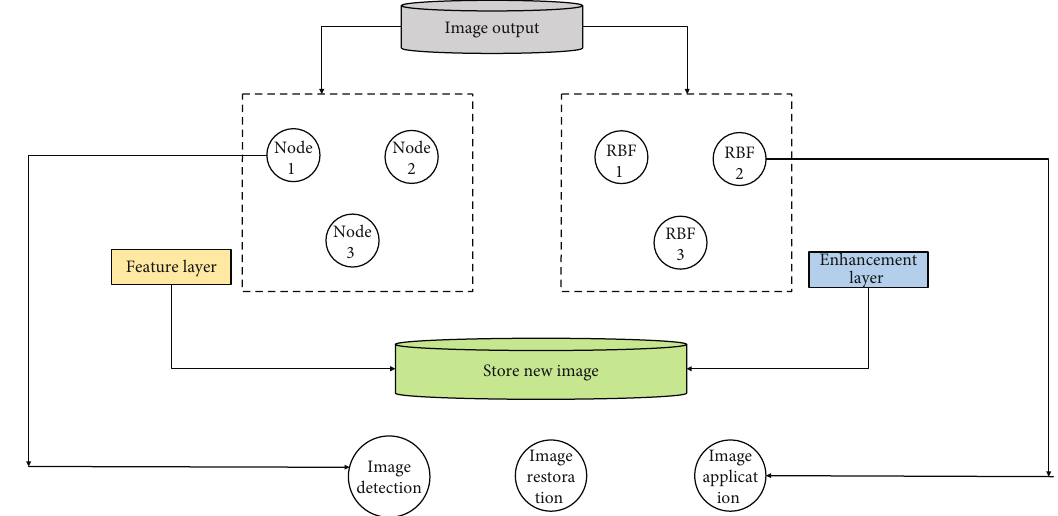
Figure 3: Radial base width learning network